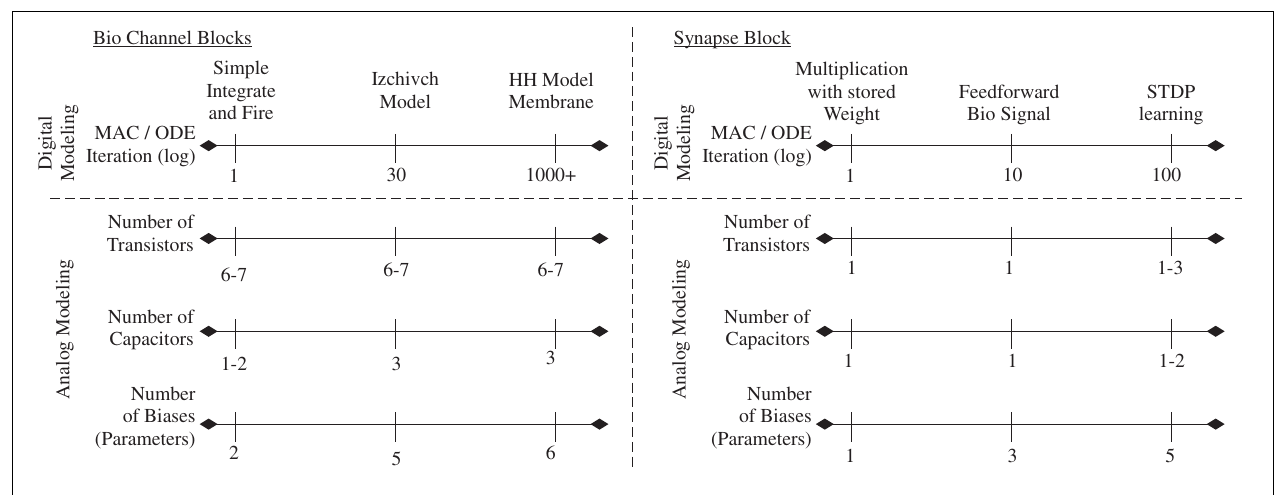
FIGURE 8 | Comparisons of implementation measures for digital and analog implementations for channel models and synapse models. A spectrum of easy to complicated aspects understood in one area (i.e., digital) might have no similar approach in the other area (i.e., physical